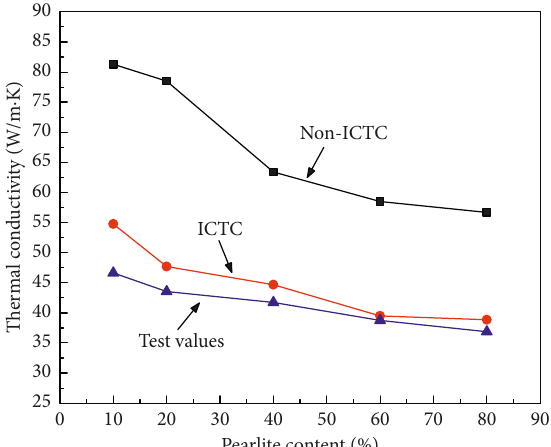
Figure 8: Thermal conductivity of CGI with different